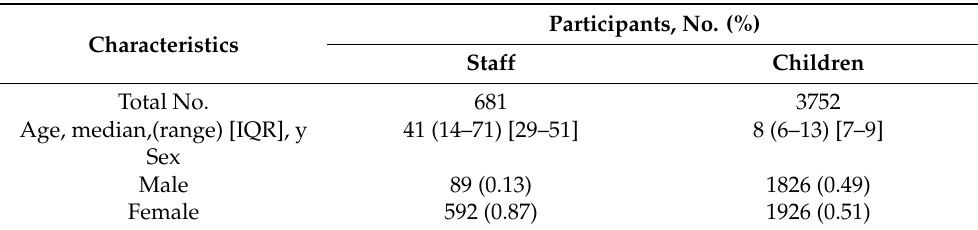
Table 1. Demographic characteristics of the study population. Abbreviations: IQR, interquartile range; y, years; No.,